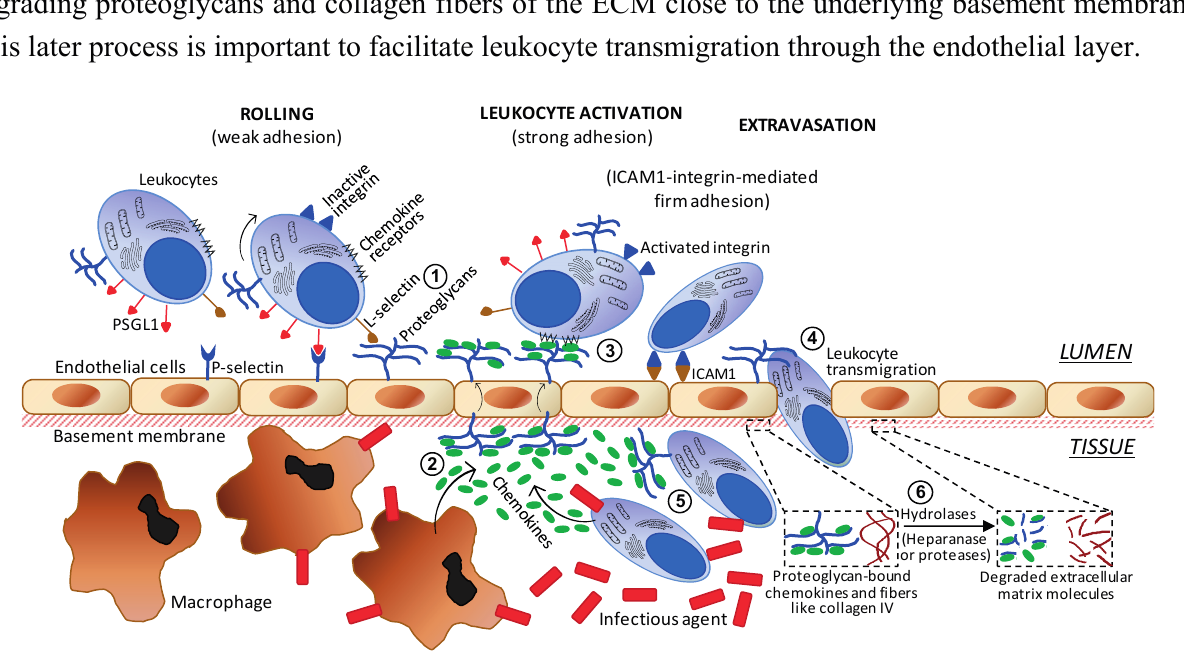
Figure 4. Simplified scheme regarding the major cells and molecular players involved in the progress of inflammation. The numbers indicate the sites of action of the anti-inflammatory sulfated glycans. Abbreviations used are TNF for tumor necrosis factor, ICAM for intercellular adhesion molecule and PSGL1 for P-selectin glycoprotein